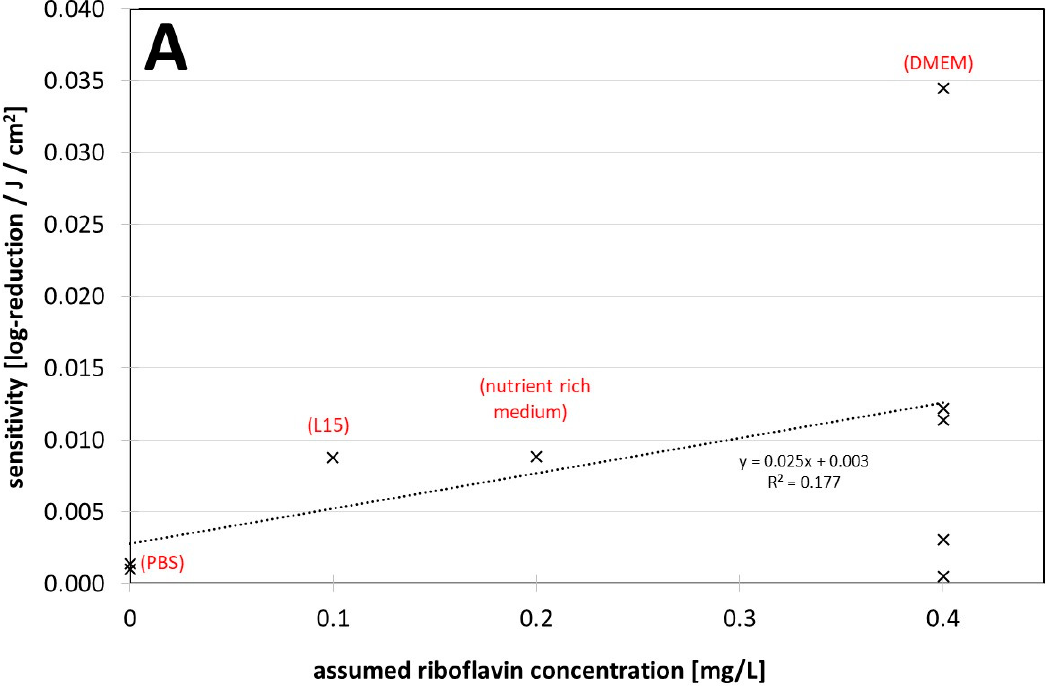
A correlation between the assumed riboflavin concentration (or the applied media) and the sensitivity (inverse of the log-reduction dose) is illustrated in Figure 2A,B for all non-enveloped and enveloped virus data, respectively. The results for both groups, with Figure 1. Boxplot of the determined necessary log-reduction dose for all, non-enveloped, enveloped those of enveloped viruses including those for all coronaviruses, show that sensitivity in- Figure 1. Boxplot of the determined necessary log-reduction dose for all, non-enveloped, enveloped and coronaviruses. Illustrated are the medians, and the quantiles of the result distribution. The num- creases with higher riboflavin concentration. However, this tendency appears to be less and coronaviruses. Illustrated are the medians, and the quantiles of the result distribution. The ber in brackets give the quantity of data sets for each virus category (not all outliers are depicted). pronounced for non-enveloped viruses. number in brackets give the quantity of data sets for each virus category (not all outliers are depicted).